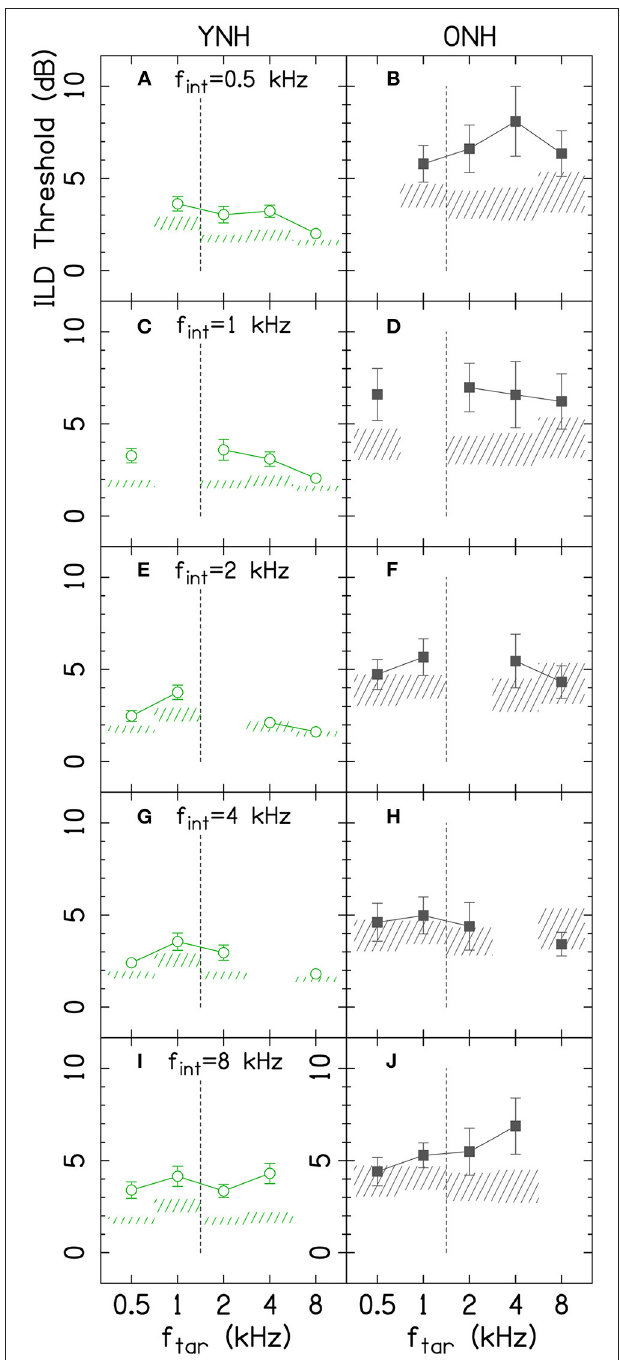
FIGURE 3 | Average ILD discrimination thresholds for target-interferer pairs are shown by data points for YNH (left column) and ONH (right column) listeners. Different rows represent different f[ int ]. Error bars on each point represent ± 1 standard error of the listener mean. The shaded areas represent the average ± 1 standard error for the single-tone conditions, which were copied from Figure 2 . The vertical dashed lines show the border where low-frequency ITDs are particularly potent. f int , interferer frequency; f tar , target frequency; ONH, older normal hearing; YNH, younger normal hearing. The YNH data have been previously reported. Reproduced from Beth Rosen and (Continued)